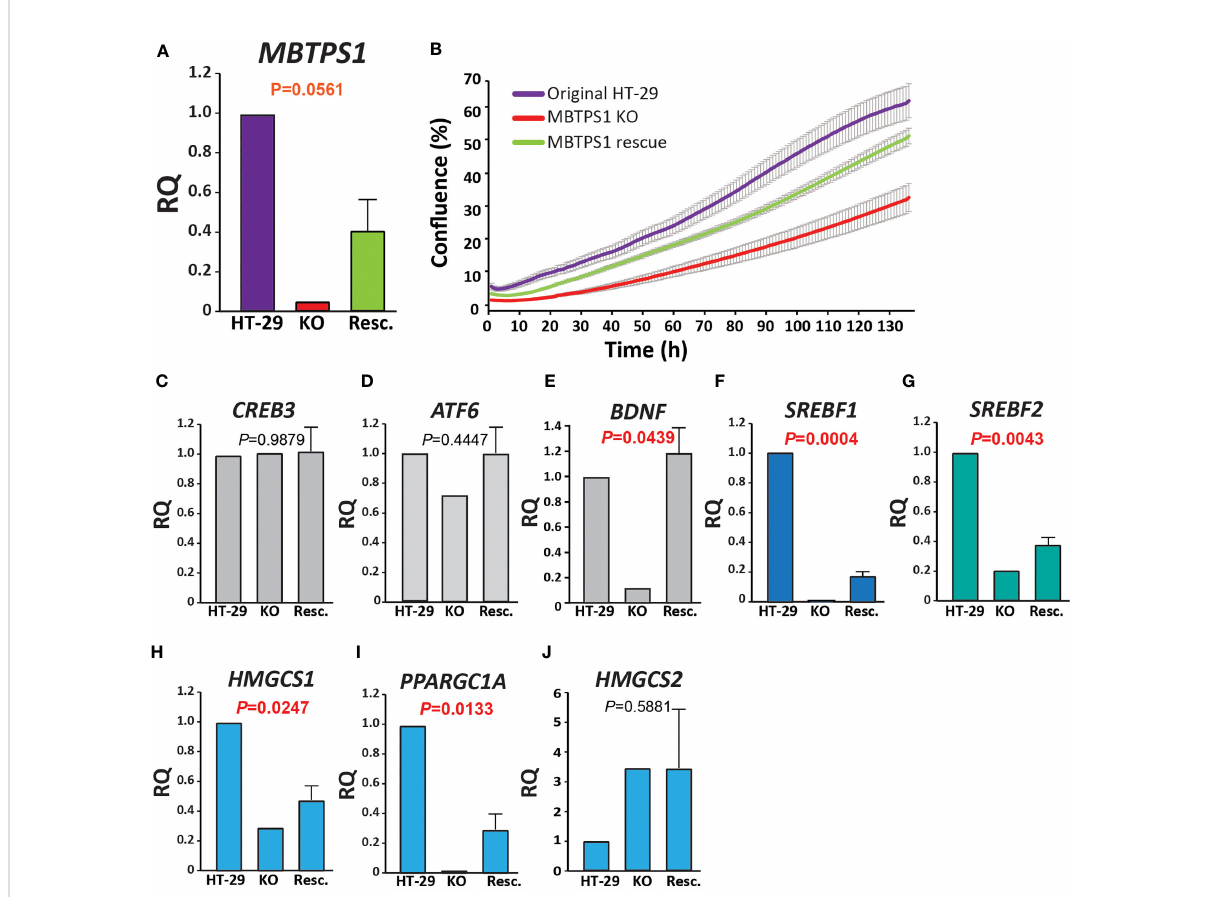
FIGURE 7 MBTPS1-mediated effect on proliferation is dependent mainly upon the SREBP pathway. (A) Relative mRNA levels of MBTPS1 in original (HT-29), MBTPS1 KO and re-expression of MBTPS1 (Rescue) HT-29 cells. P -values indicate a signi fi cant difference between KO and Resc. HT-29 cells Reintroduction of the MBTPS1 gene into the KO cells resulted in partial recovery of its mRNA levels ( n =4). (B) Proliferation of HT-29,